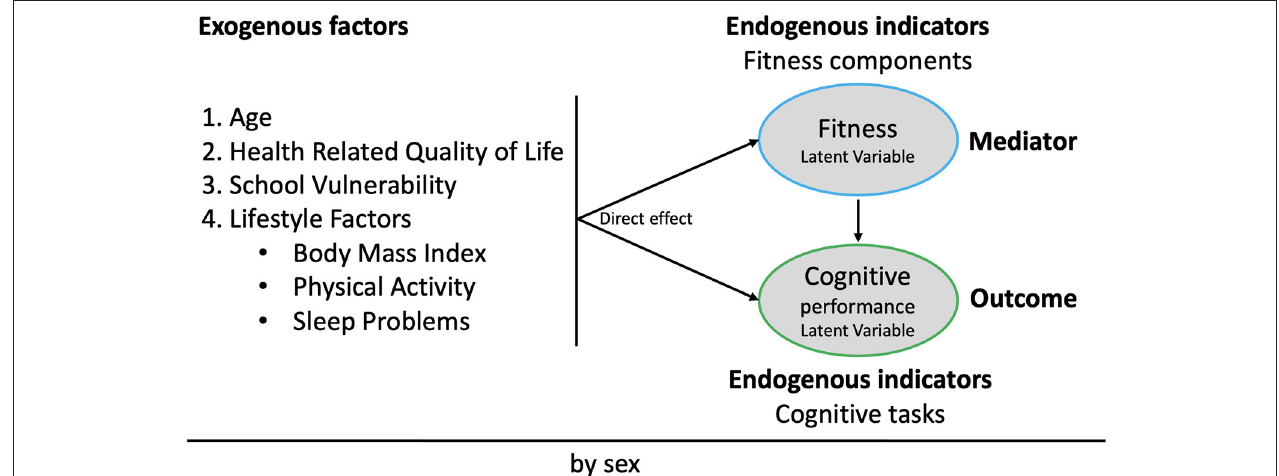
FIGURE 1 | Proposed structural mediation model adapted from previous studies (38–45).